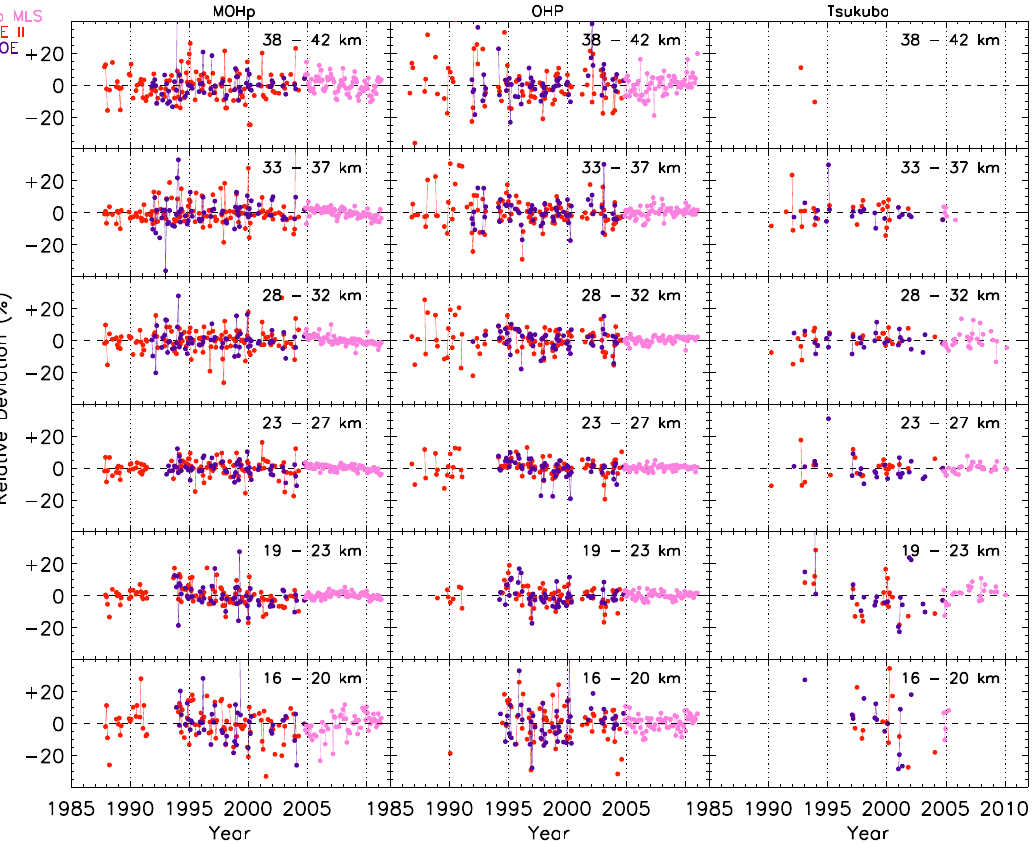
Fig. 8. Temporal evolution of the bias-removed monthly averages of the relative differences of SAGE II, HALOE and Aura MLS with ozone lidar at MOHp (left panel), OHP (middle panel) and Tsukuba (right panel). The dashed horizontal line represents